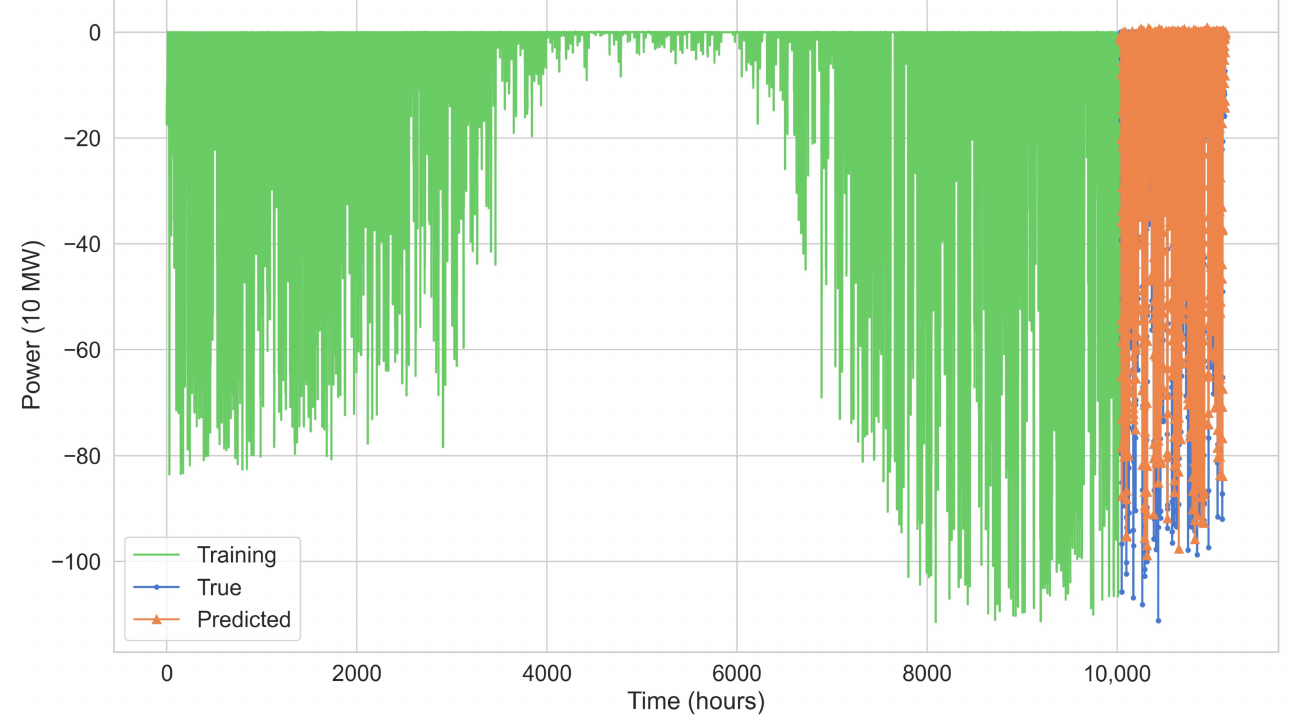
Figure 9. True vs. Predicted PV capacity output with training data.